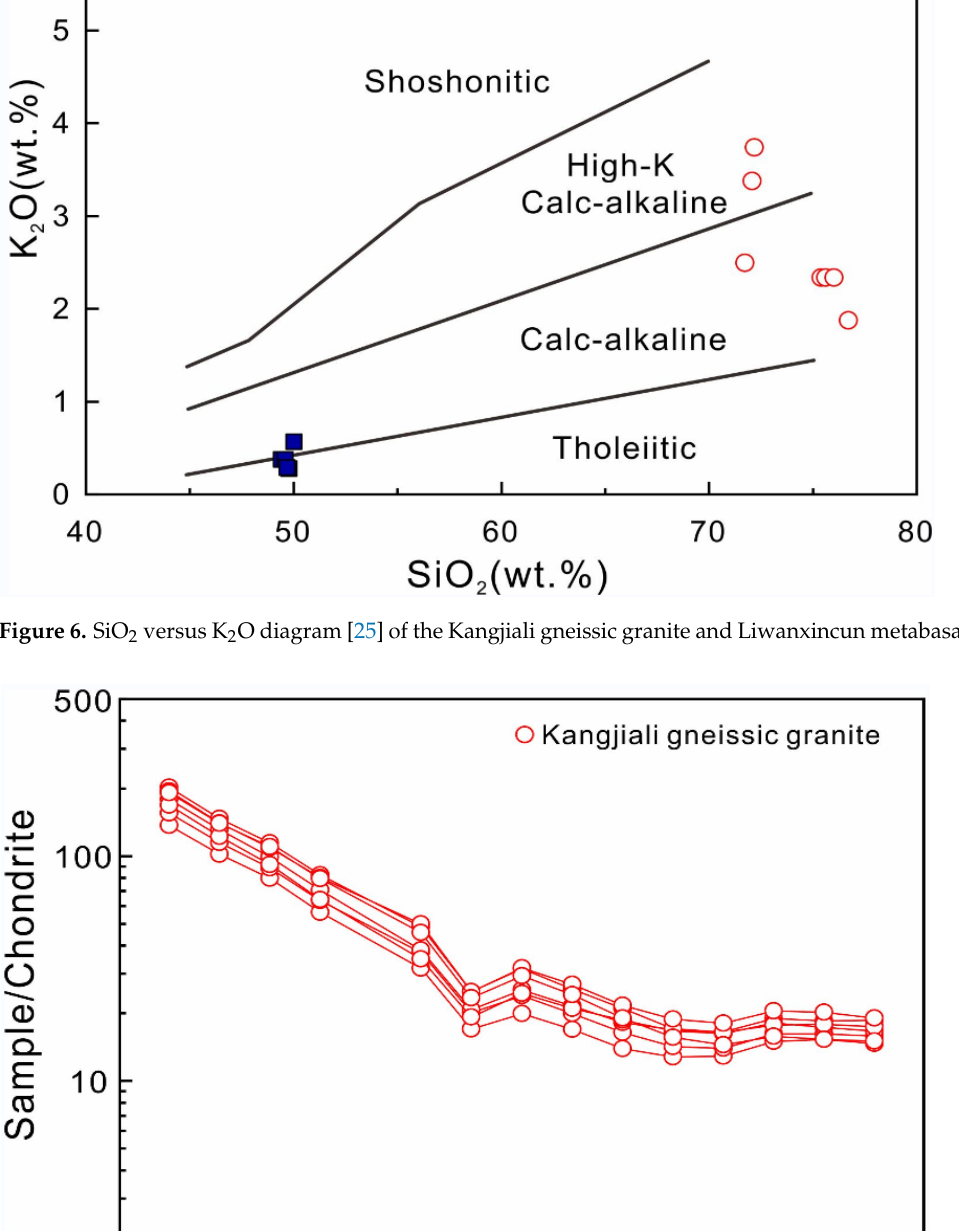
Figure 8. Primitive-mantle-normalized trace element diagram of the Kangjiali gneissic granite. Primitive mantle data are from Sun and McDonough (1989) [26].